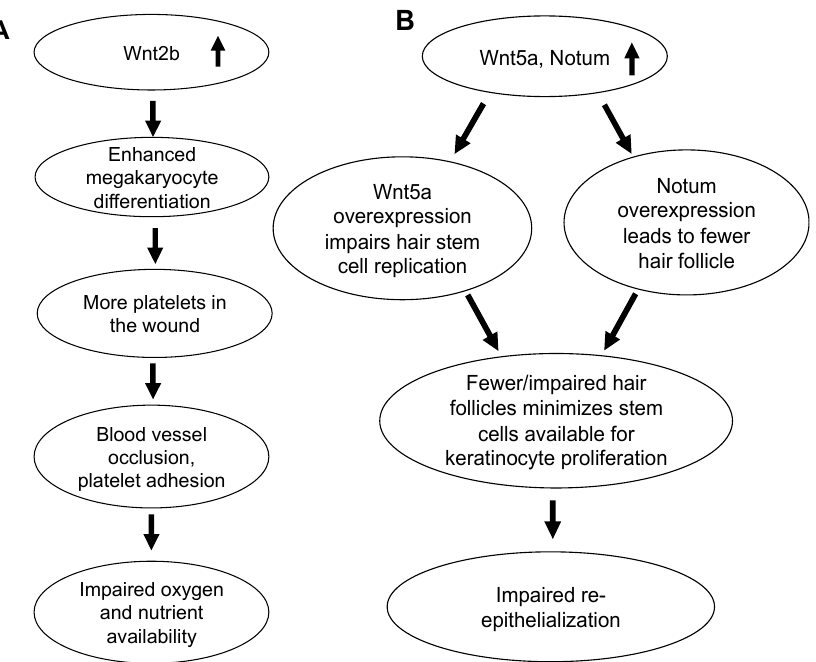
Figure 7. Wnt signaling is dysregulated in fully chronic wounds. During full chronicity, Wnt2b, Wnt5a, and Notum are overexpressed. ( A ) Wnt2b overexpression is seen during differentiation of megakaryocytes that give rise to platelets. Excess platelets during full chronicity may cause blood vessel occlusion and platelet adhesion and blocks oxygen and nutrients from reaching the wound.